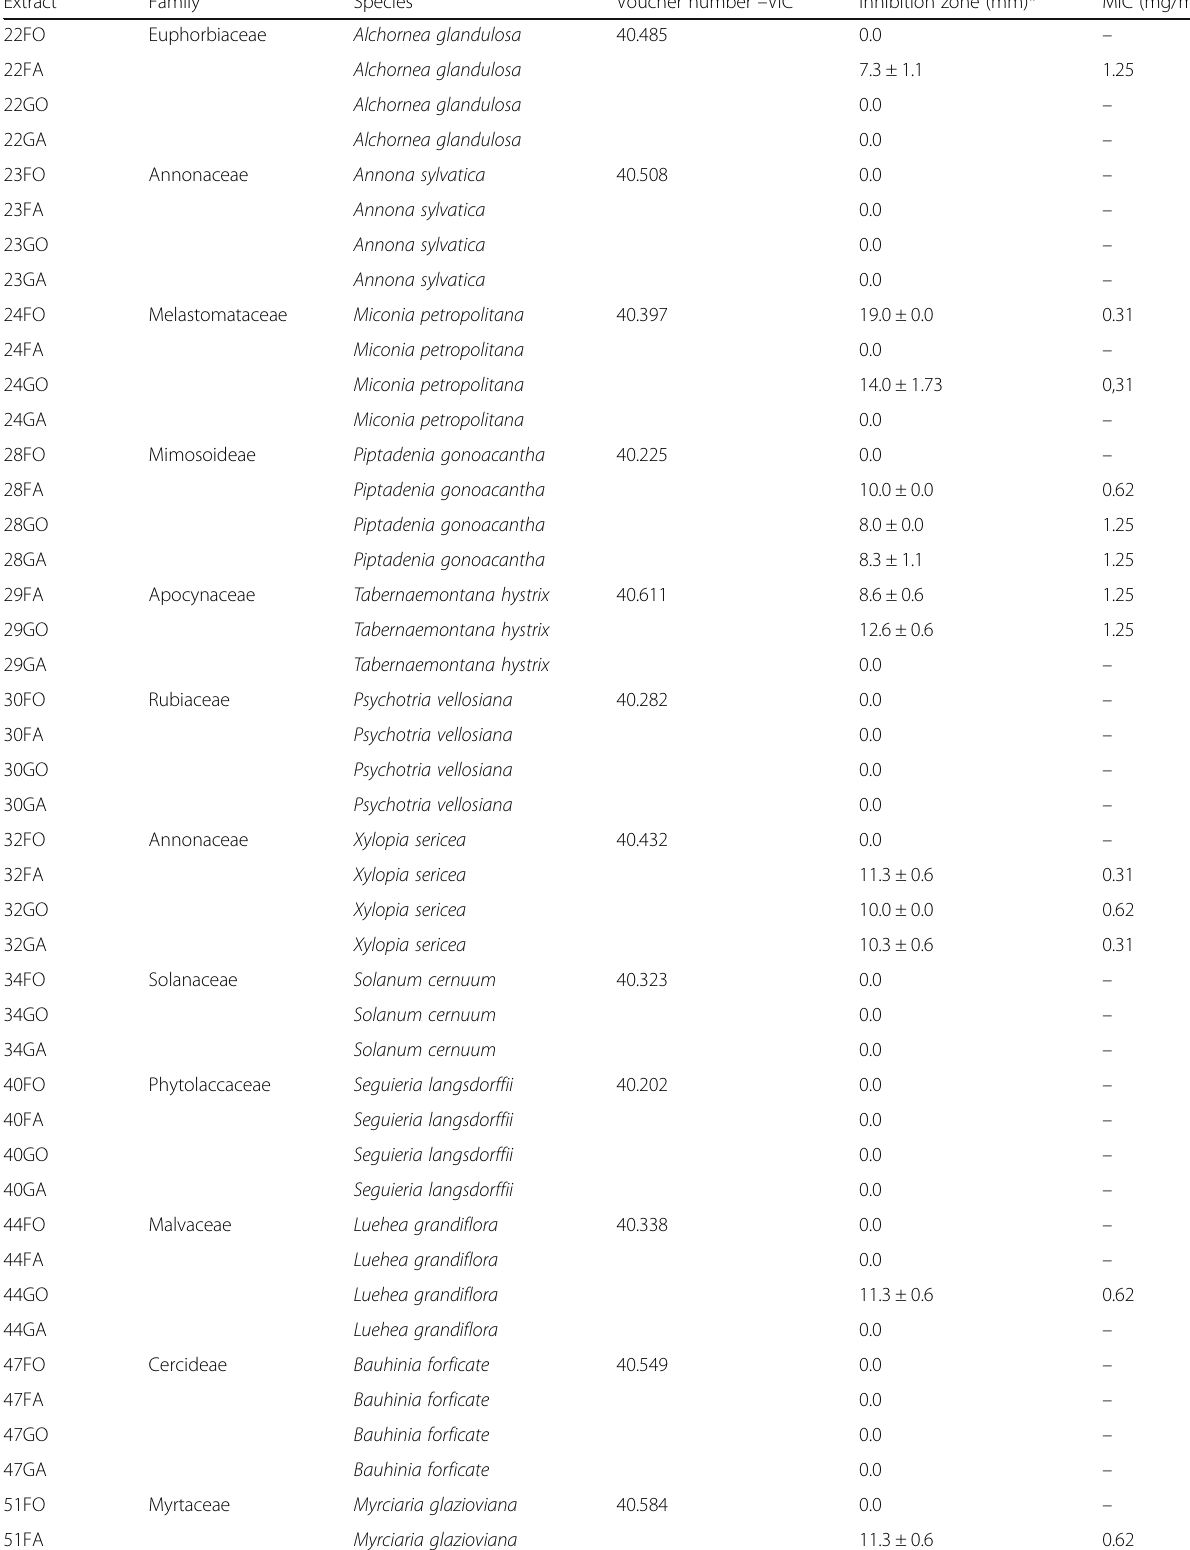
Table 1 Antimicrobial activity of plant extracts against Staphylococcus aureus ATCC 29213 (Continued)